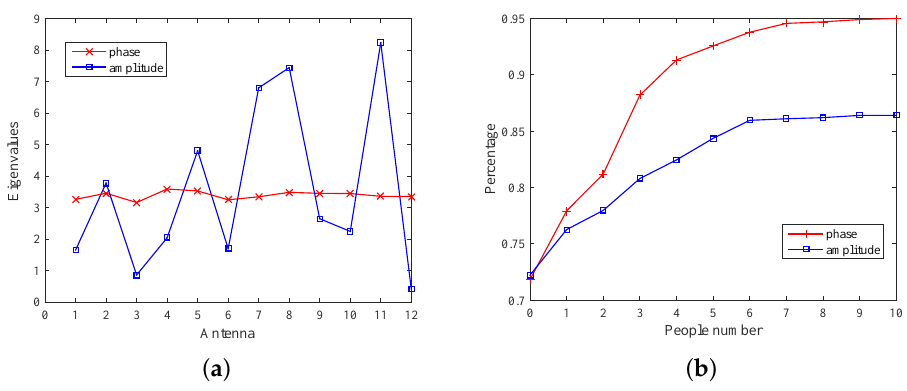
Figure 9. Comparison of amplitude and phase. ( a ) Comparison of mean in eigenvalue; ( b ) the relationship between percentage and the number of people.